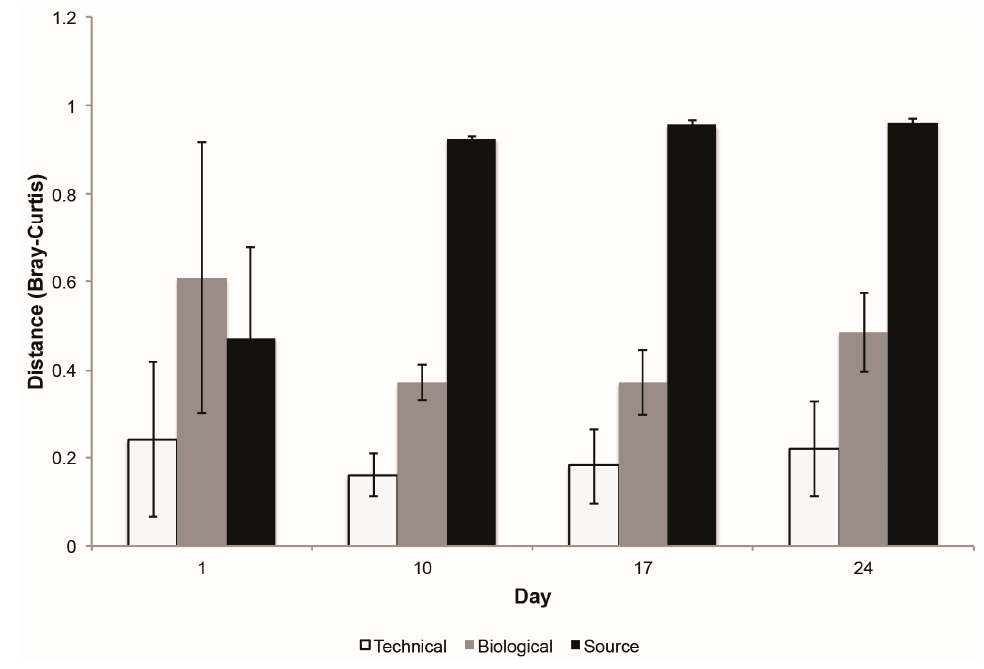
Figure 4. The average Bray-Curtis distance between technical replicates (T), biological replicates (B) and the distance it diverged from the starting inoculum community (S) each day. Numbers following single letter comparison group designations indicate the day of the experiment (e.g., S24 is the distance between 24-day columns and inoculum community). More similar communities have a lower Bray-Curtis distance. The average distance between technical replicates is significantly different than the average distance between biological replicates. Average distances between biological and technical replicates are statistically significantly different ( t -test and Wilcoxon rank sum p -value < 0.001) for all days. Average distances between biological replicates and the inoculum community are statistically significantly different from average distances between technical and biological replicates ( p < 0.001) for all days, except for the day 1 samples.